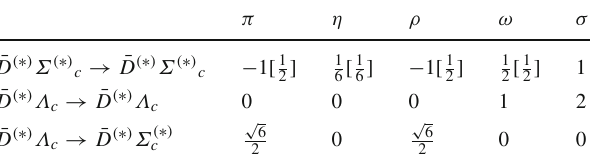
Table2 Theflavorfactorsforcertainmesonexchangesofcertaininter- action. The values in bracket are for the case of I = 3 / 2 if the values are different from these of I = 1 / 2